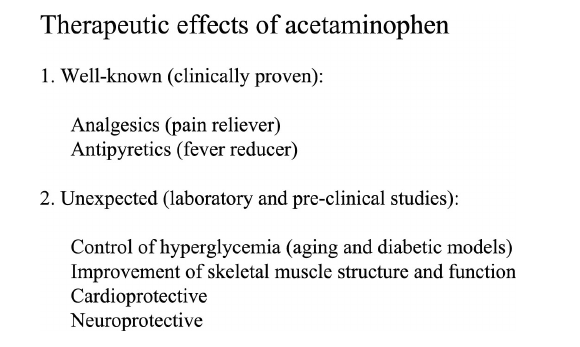
FIGURE 2 | Summary of acetaminophen therapeutic effects. In addition to the clinically proven analgesic/antipyretic properties, laboratory and pre-clinical studies demonstrated that acetaminophen has other beneficial effects that would increase clinical application of acetaminophen. However, clinical studies are needed to ensure its safety, efficiency, and proper